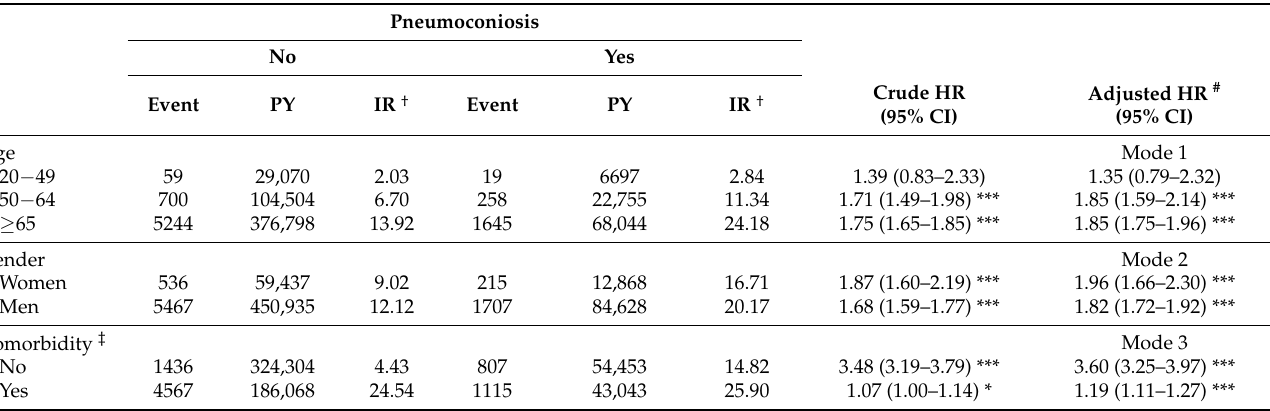
Table 3. Incidence rates and hazard ratios of chronic kidney disease for individuals with and without pneumoconiosis by age, gender, and